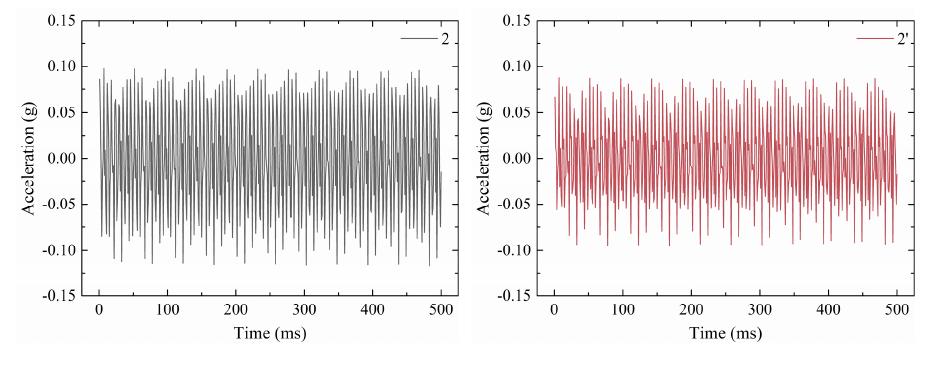
Figure 18. Acceleration responses of nodes 2 and 2’ in case 3.